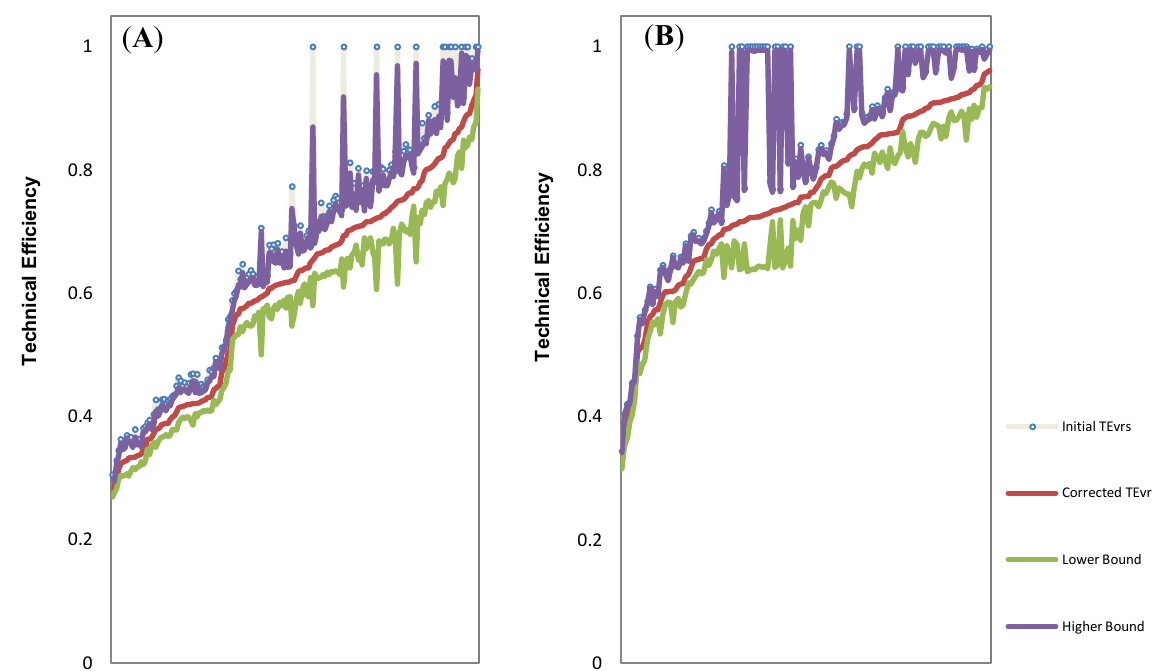
Figure 1. Initial and bias corrected Technical efficiency scores ( A ) Potato